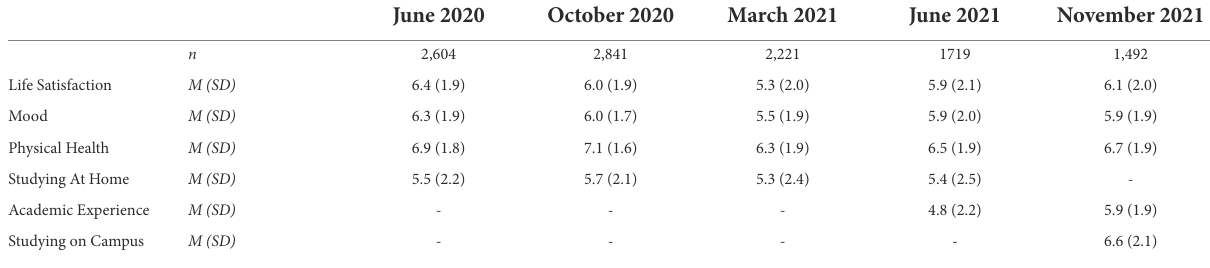
TABLE 2 An overview of data gathered in five iterations through scaled items about student wellbeing at Delft University of